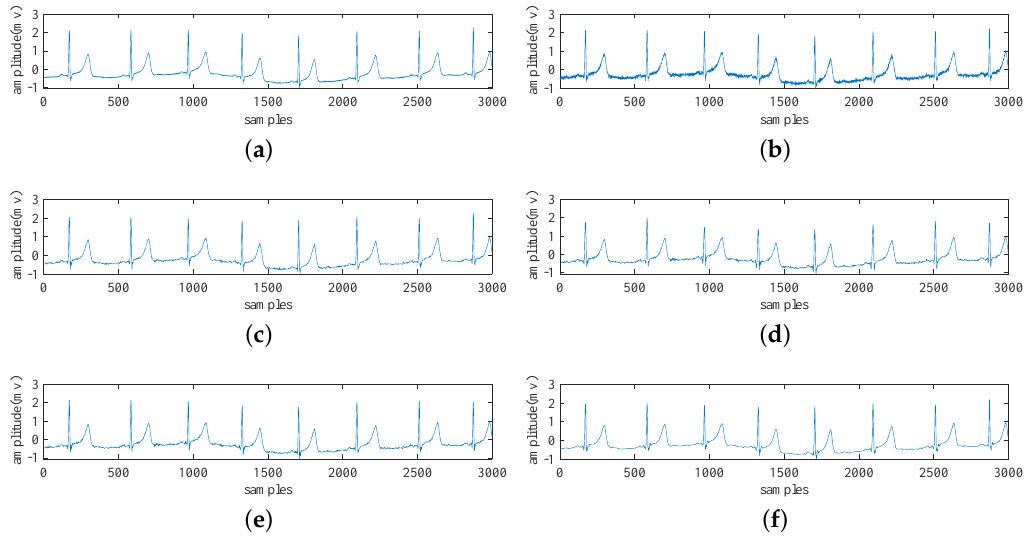
Figure 6. The de-noising results of adding 20 dB WGN to No. 113 record of the MIT-BIH database: ( a ) The original signal. ( b ) The signal after adding 20 dB WGN. ( c – f ) De-noised signals using wavelet soft threshold, EMD, EMD soft threshold, proposed